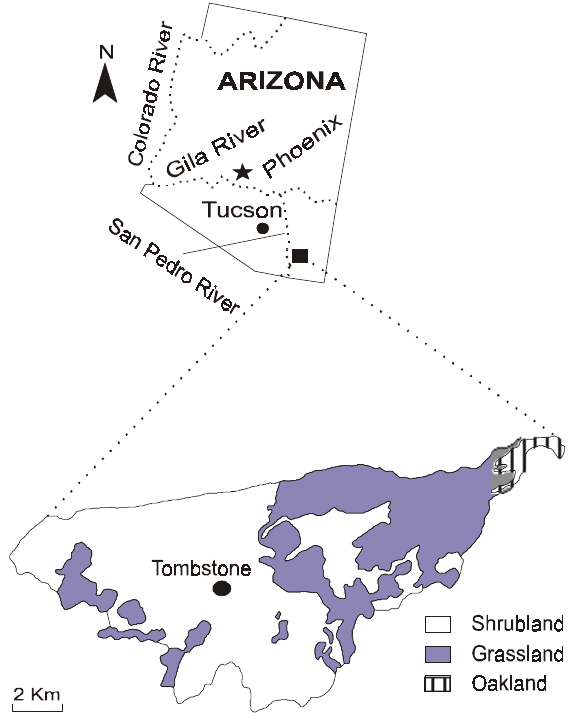
Figure 1. Map of the Walnut Gulch Experimental Watershed showing its geographical location in the State of